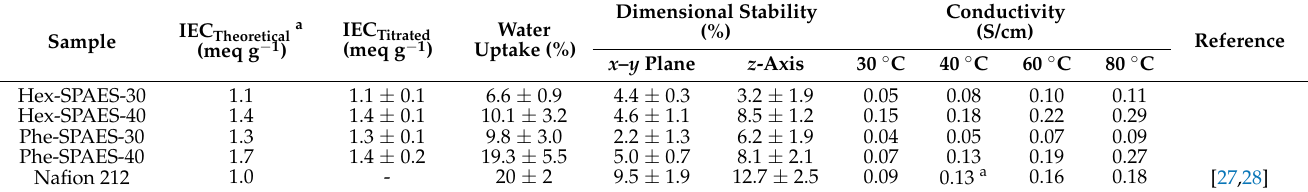
Table 2. IEC, water uptake, dimensional stability, and conductivity values for the synthetic polymer membranes. IEC Titrated IEC Theoretical a Sample (meq g − 1 ) (meq g − 1 )